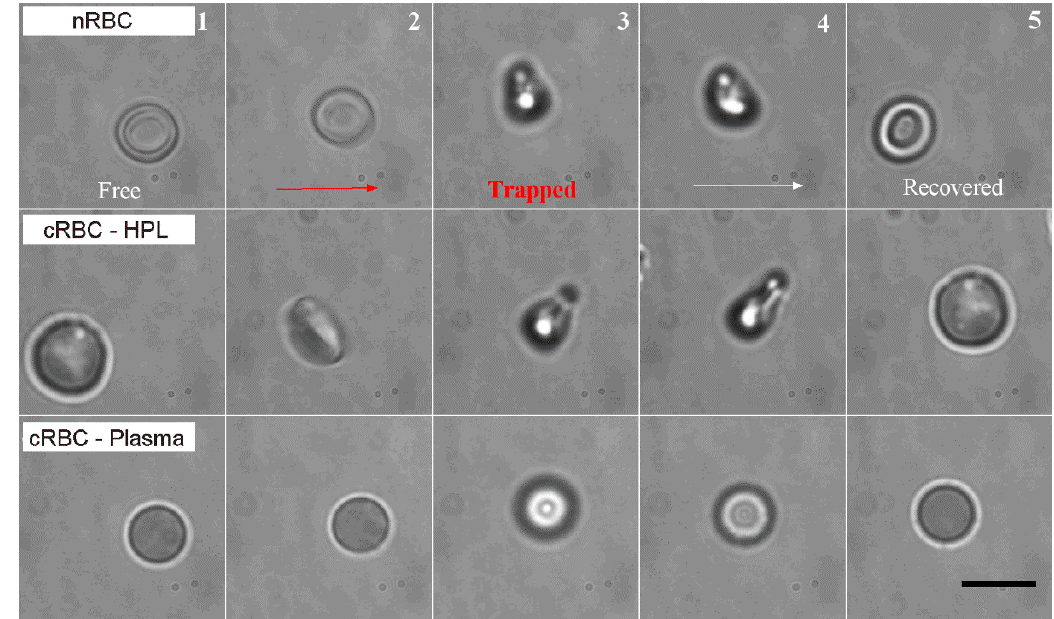
Figure 3. Deformation of nRBCs and cRBC HPL as well as cRBC Plasma during optical trapping. (1) Cell laid on the substrate; (2) cell begins to be attracted to the trap; (3) cell folded in a stable shape during trapping; (4) cell just released from the trap, laser trap off; (5) cell recovering its shape (biconcave shape). Scale bar: 10 µm. HPL = human platelet lysate